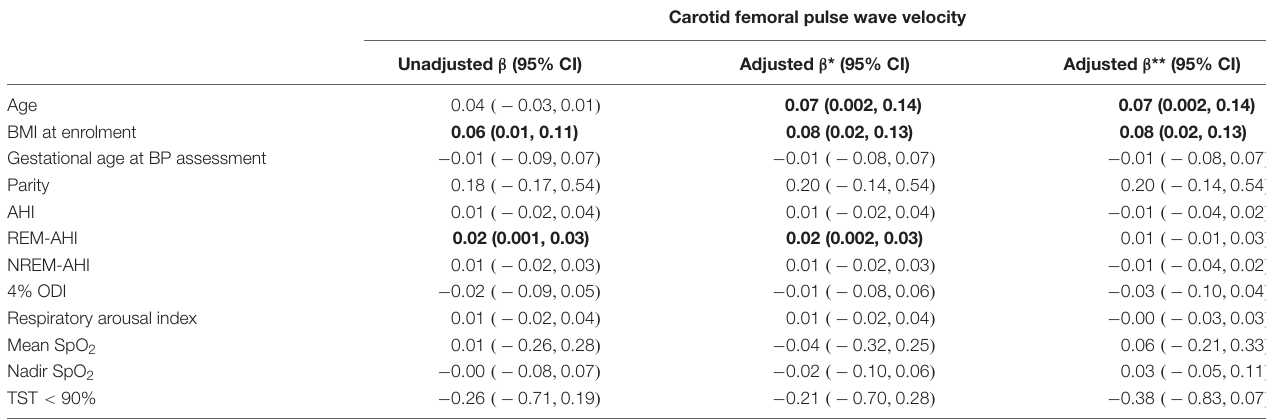
TABLE 7 | Regression models for association between carotid femoral pulse wave velocity and demographics and obstructive sleep apnea severity measures.